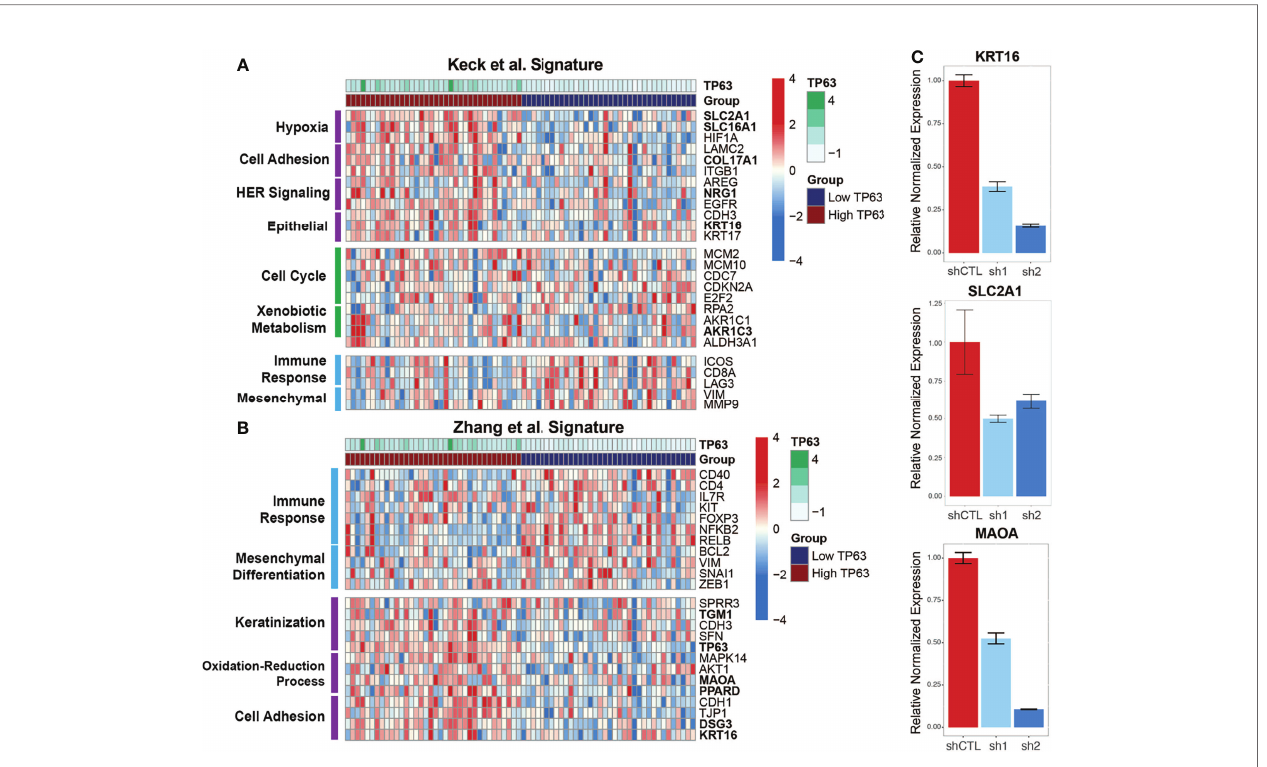
FIGURE 5 | p63 high and p63 low groups recapitulate published HPV+ HNSCC subtype gene signatures. (A) Heatmap representation of expression of genes from the Keck et al. (14) signature within the p63 high and p63 low HPV+ HNSCC TCGA samples. DEGs are separated based on distinct patterns of expression between the p63 high and p63 low groups. Speci fi c biological and signaling pathways associated with the DEGs are indicated. Bolded genes represent those that were included in the consensus p63-derived gene signature. (B) Heatmap representation of expression of genes from the Zhang et al. (11) signature within our p63 high and p63 low HPV+ HNSCC TCGA samples. DEGs are divided up by patterns of expression between the p63 high and p63 low groups. Speci fi c biological and signaling pathways associated with the DEGs are indicated. Bolded genes represent those that were included in the consensus p63-derived gene signature. (C) Graph showing qRT-PCR results for normalized expression of 3 key genes in SCC104 cells expressing shCTL and p63